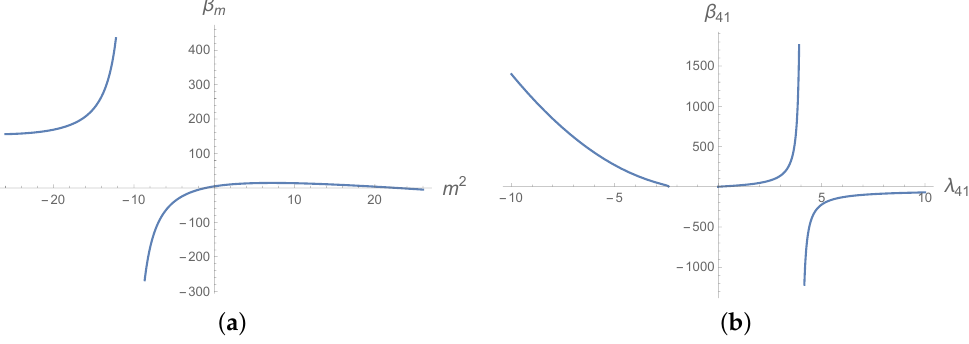
( a ). Plot of β 41 as function of 576 π 2